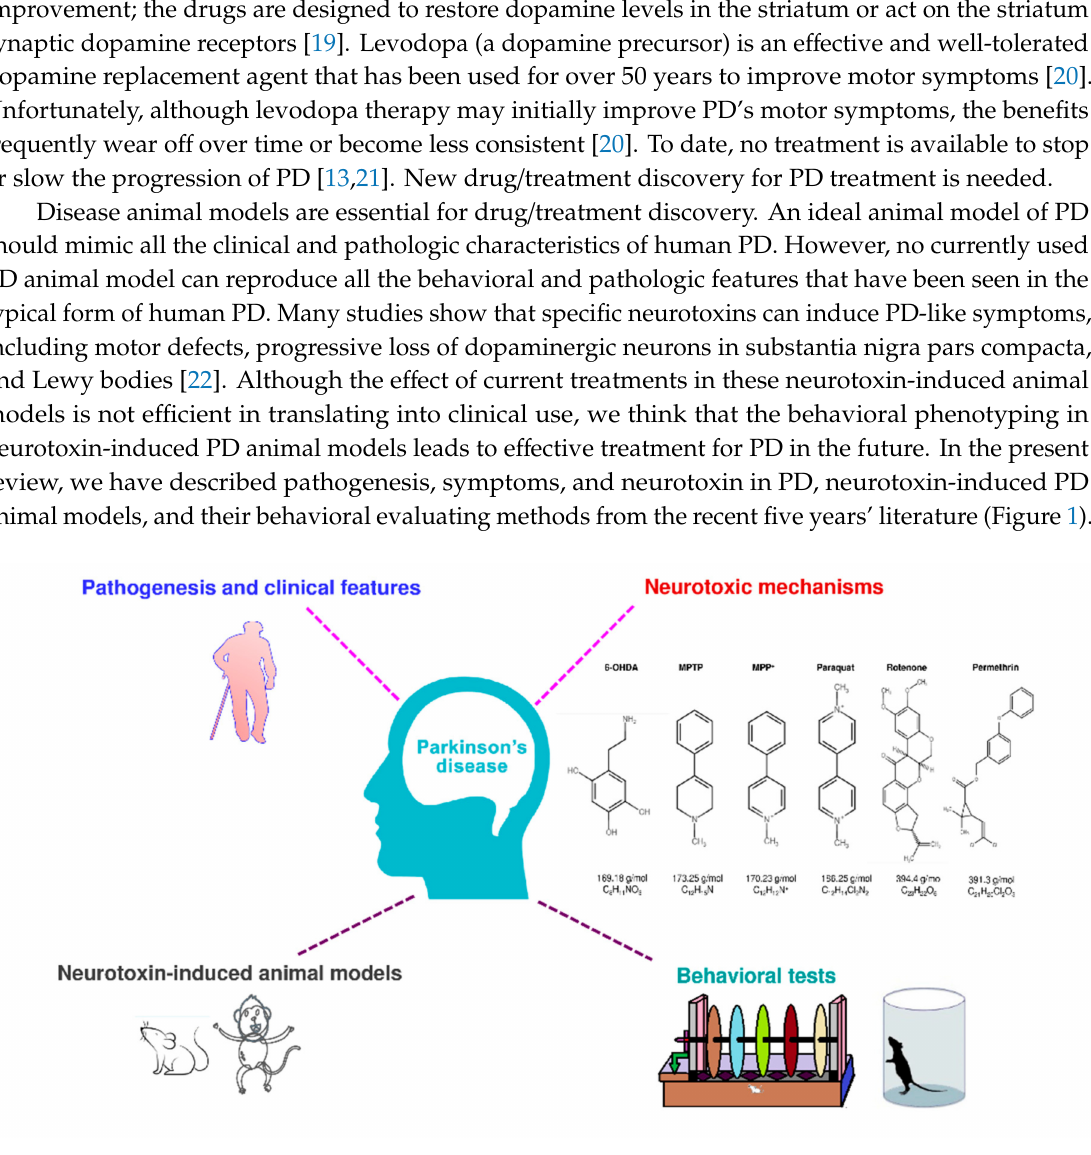
Figure 1. Graphic representation of pathogenesis, neurotoxic mechanisms, neurotoxin-induced animal models, and their behavioral